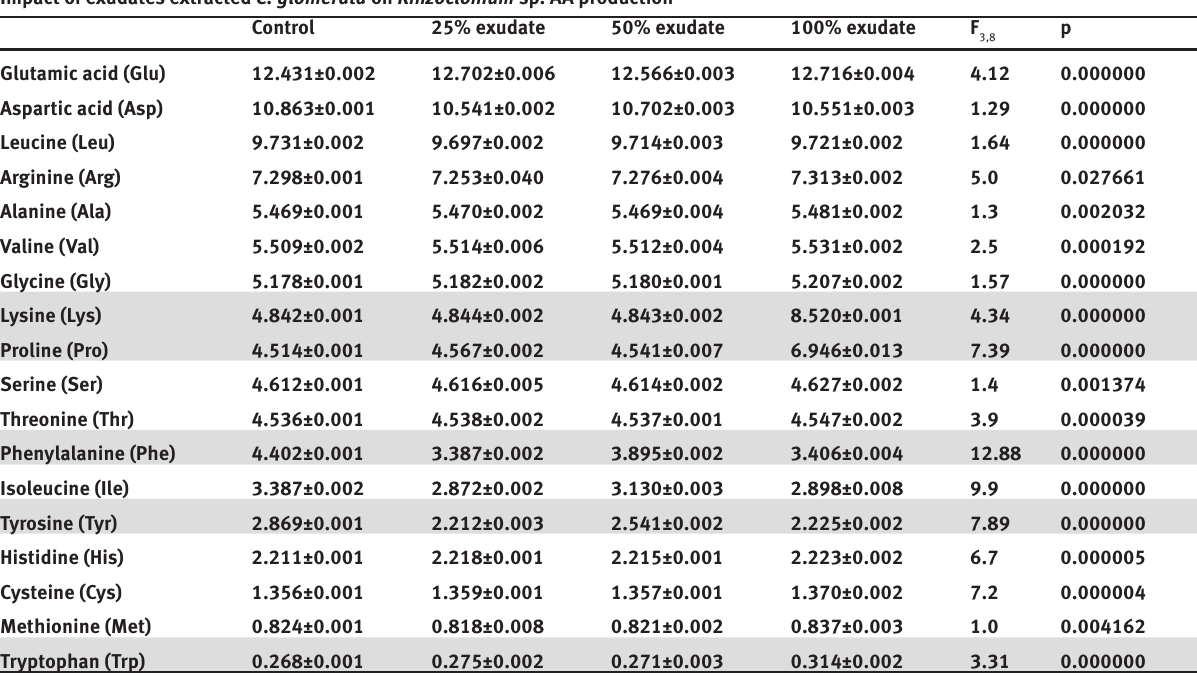
Table 4: The content of amino acids (AA) in Rhizoclonium sp. biomass (g·100g -1 of total proteins; df=3; bold - statistically significant, p<0.05; gray selection - fluctuation in the content of amino acid > 10%).